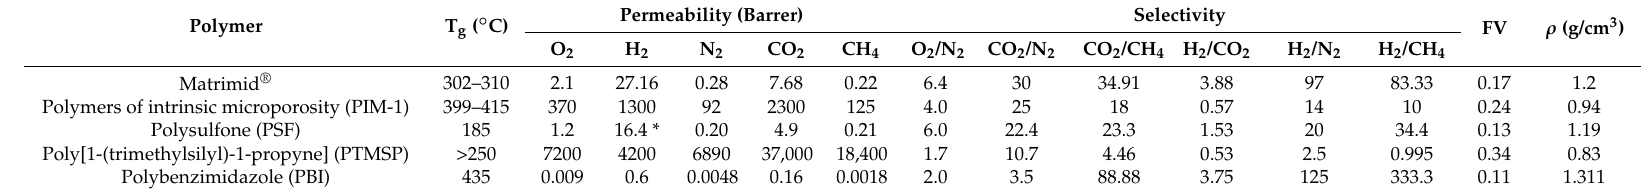
Table 2. Features of Matrimid ® 5218 membranes compared to other polymeric membranes for different gas separations. Adapted from [4].